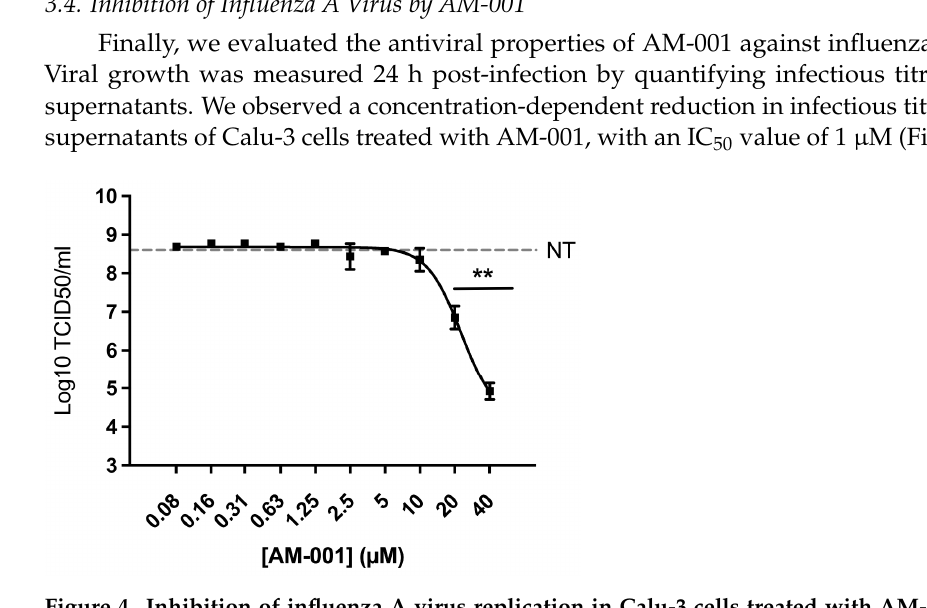
Figure 4. Inhibition of influenza A virus replication in Calu-3 cells treated with AM-001 . Cells pretreated for two hours with the indicated concentrations of AM-001 or with an equivalent concen- tration of DMSO (non-treated control NT) were infected at a multiplicity of infection of 0.001 with influenza A virus. After one hour of virus inoculation, the cell culture medium was removed and replaced with cell culture medium containing AM-001 at the indicated concentrations. Infectious particles were measured 24 h post-infection. Results are expressed as means ± SEM from three inde- pendent experiments. Statistical analysis: one-way ANOVA with Dunnett’s multiple comparisons test (** indicates p < 0.01 compared to NT cells). The dotted gray line corresponds to the mean result from NT